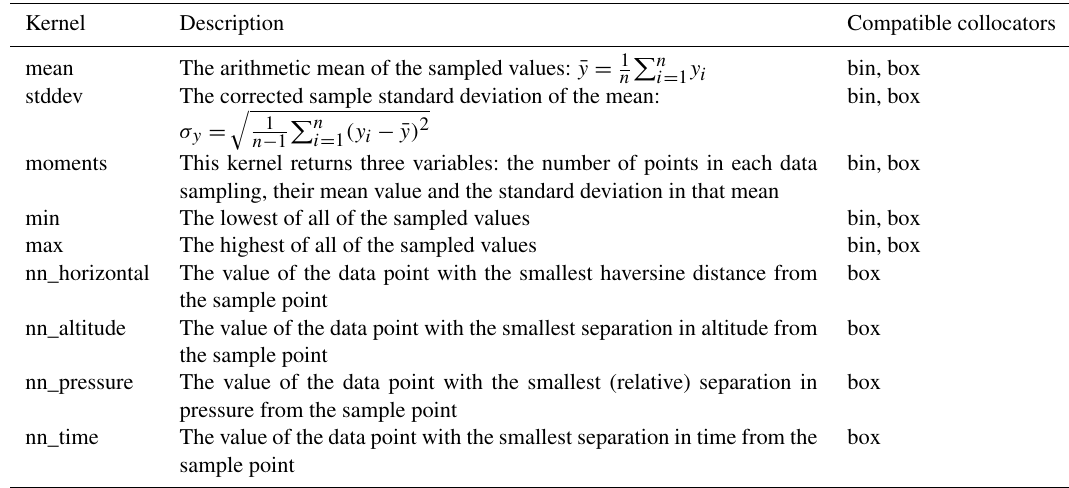
Table 4. A list of the different kernels available. Note that not all of the kernels are compatible with all of the collocators.